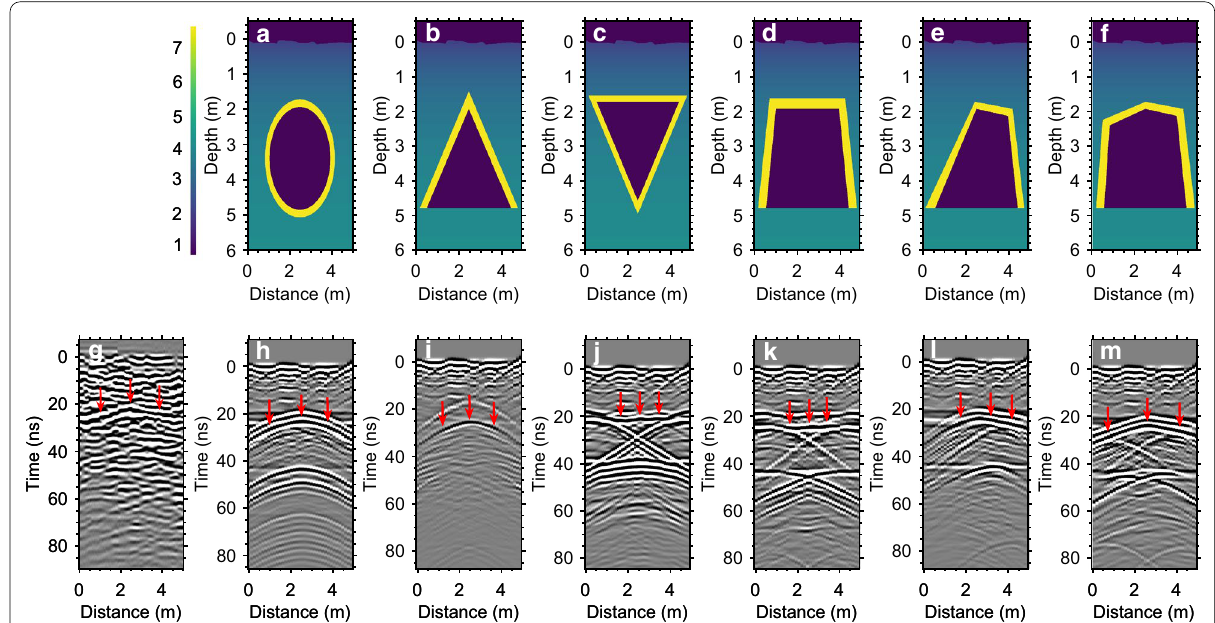
Fig. 3 Representative subsurface cavity models are used to compare the morphology of the upper hyperbolic echo pattern in the radargram. The cavities have different assumed roof shapes, which are supported by basaltic boulders. Similar models are introduced in Additional file 1: Text S2. The basic model setups are introduced in "Method" section. The first row introduces models that consider different roof morphologies of the subsurface cavity, and the bottom row shows both the observation (panel g ) and corresponding simulation results. The two criteria used